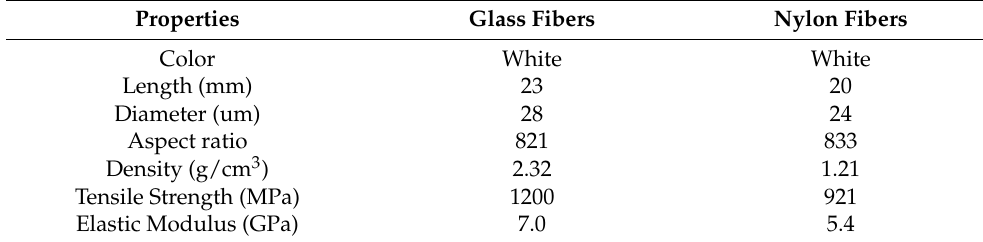
Table 3. Properties of glass and nylon.